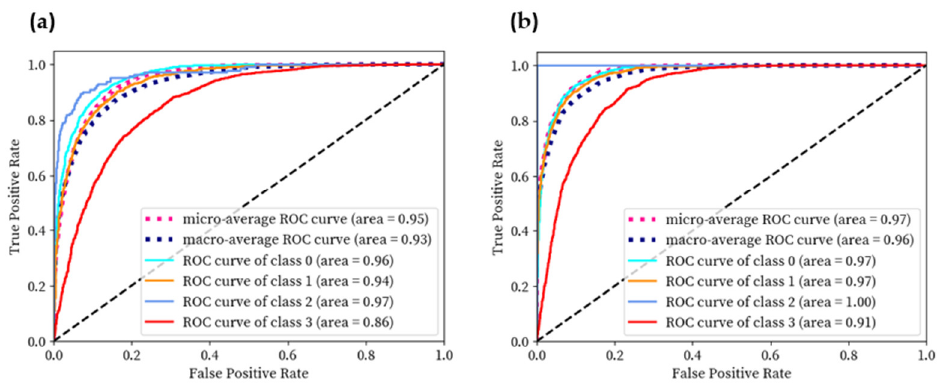
Figure 8. The ROC curves of classification. ( a ) Four-stage classification of original images; ( b ) four- stage classification of generated images.